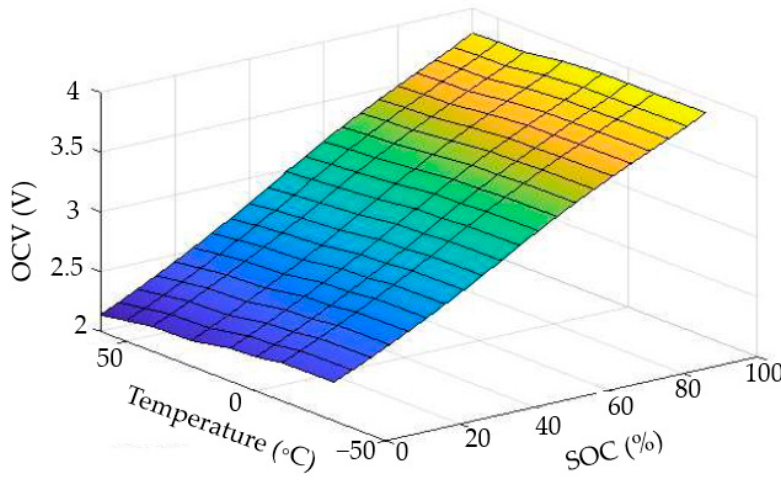
Figure 5. The experimental curve for the OCV–SOC of the LiC cell.